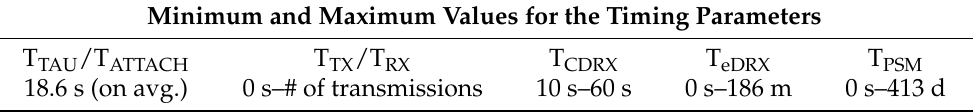
Table 7. Timings parameters of the BG96